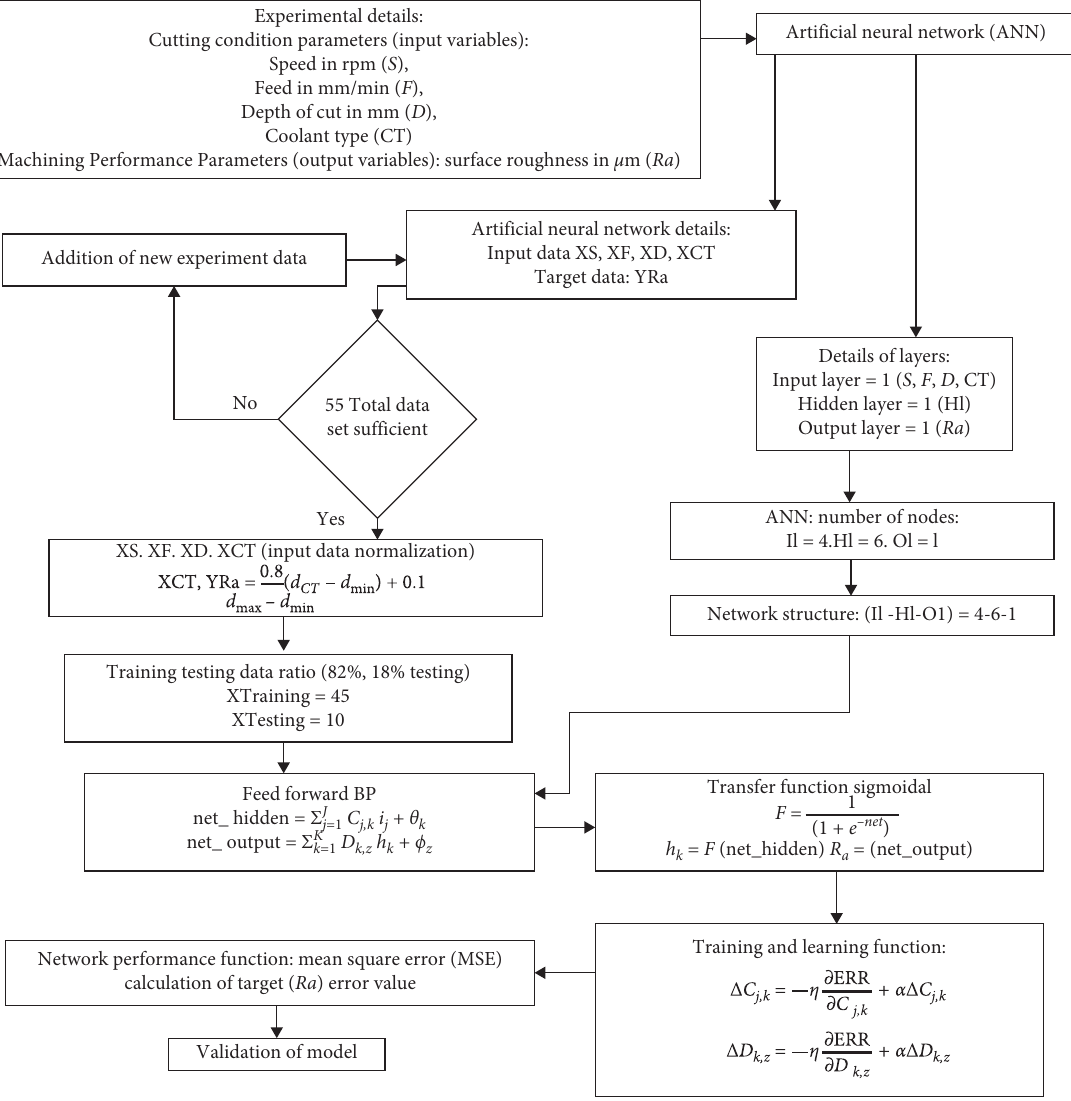
Figure 9: ANN model flow of